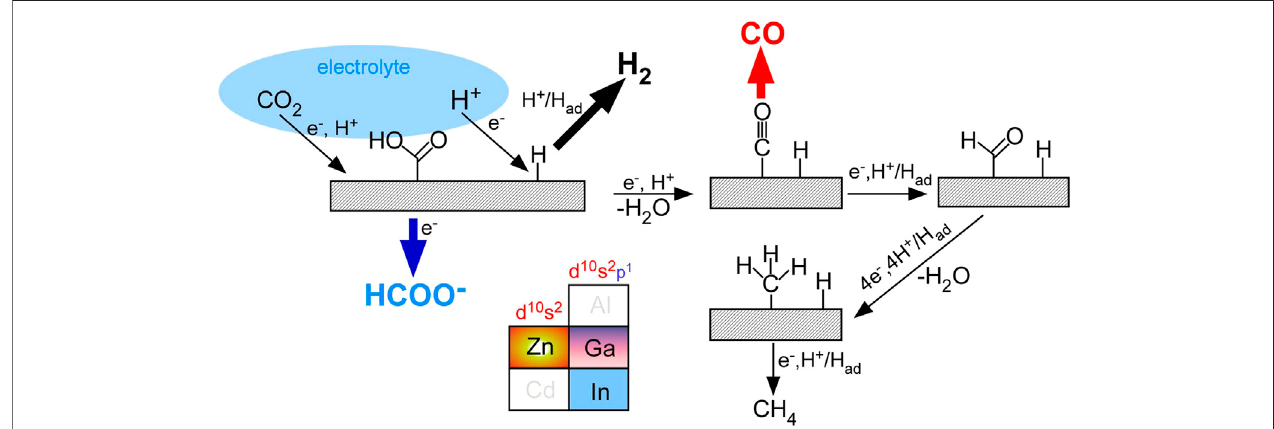
FIGURE 8 | CO 2 reduction mechanism for major CO 2 reduction